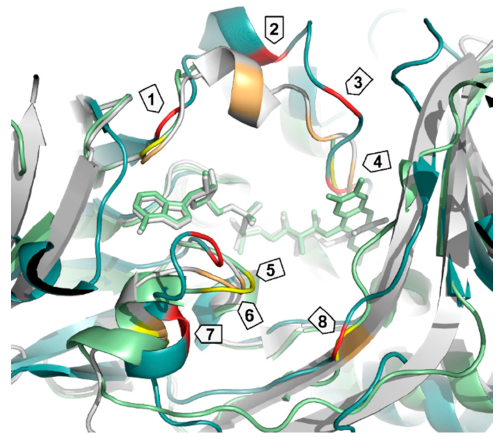
Figure 8. Comparison of the cofactor-binding site of p -hydroxybenzoate hydroxylase (PHBH) with 2-aminobenzoylacetate N -hydroxylase (PqsL) and SMOA. The crystal structures of SMOA (light teal) is compared with the group A enzymes PqsL (PDB ID: 2X3N, pale green) [12] and PHBH (PDB ID: 1PBE, grey) [155]. Critical residues for nicotinamide binding in PHBH are indicated (light orange) as well as the respective residues in SMOA (red) and PqsL (yellow). Numbering is in accordance with Table 3. The FAD ligands are shaded like the respective protein backbone. Table 3. Comparison of critical amino acid residues that are probably involved in nicotinamide binding in PHBH with respective residues of StyA and PqsL [12,151].